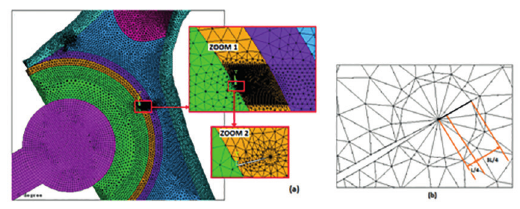
Figure 7: (a) Mesh model and (b) Special elements used for DET.